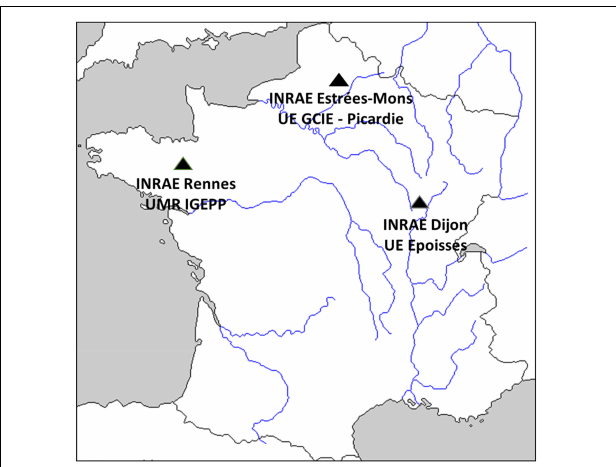
FIGURE 1 | Location of the French National Research Institute for Agriculture, Food and Environment (INRAE) experimental sites of Dijon, Estrées-Mons and Rennes.